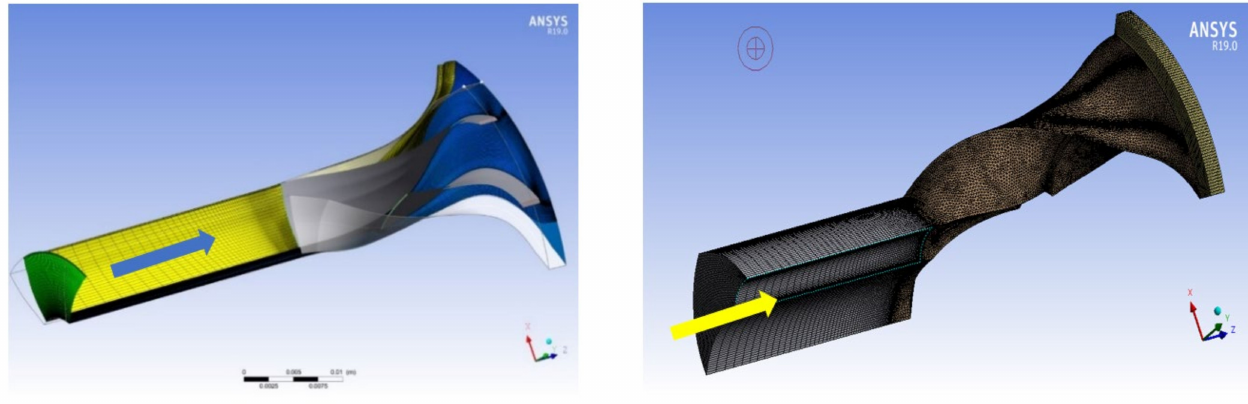
Figure 12. The final mesh for the conventional ( left ) and tandem compressor ( right ). Arrows indicate flow